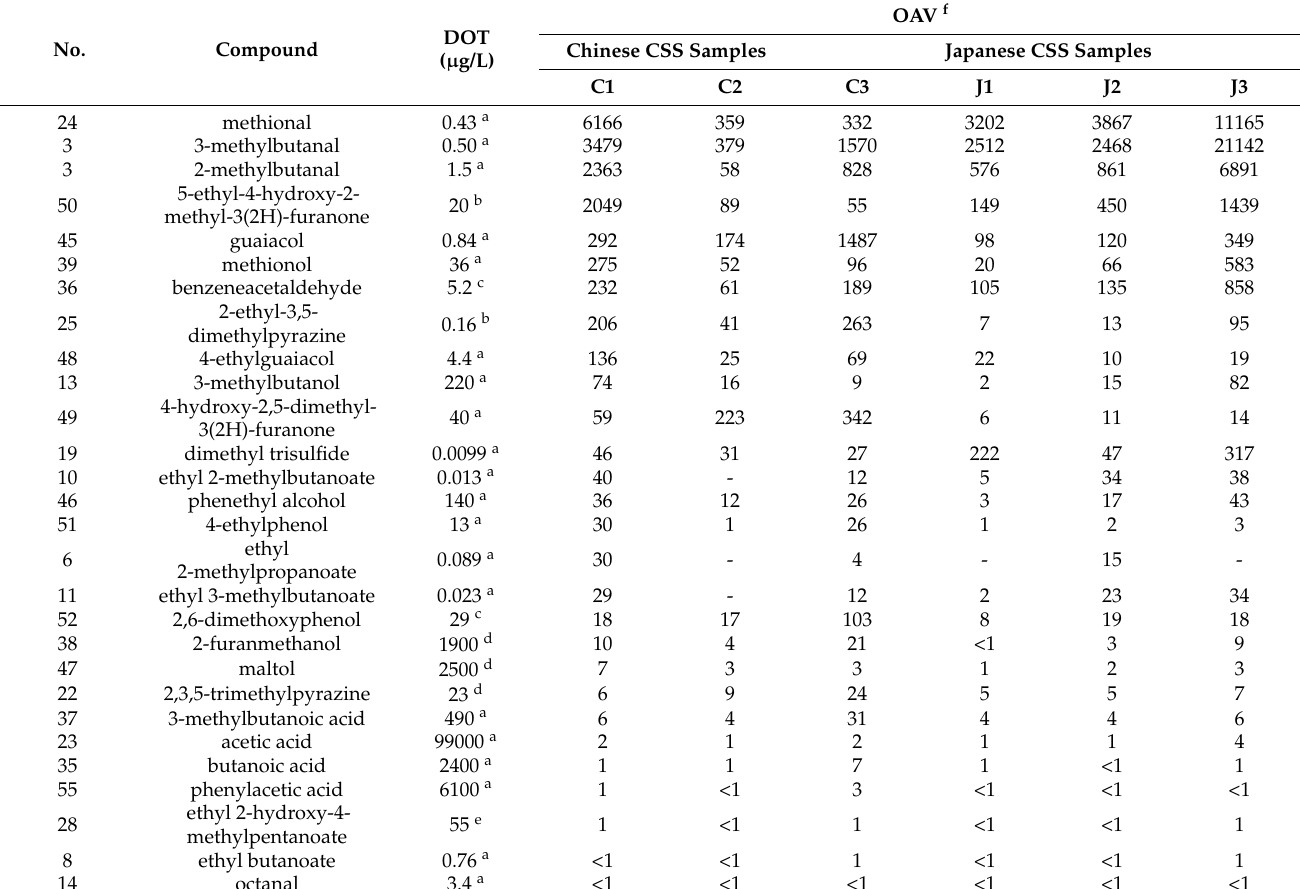
Table 5. OAVs of 28 aroma compounds in six CSS